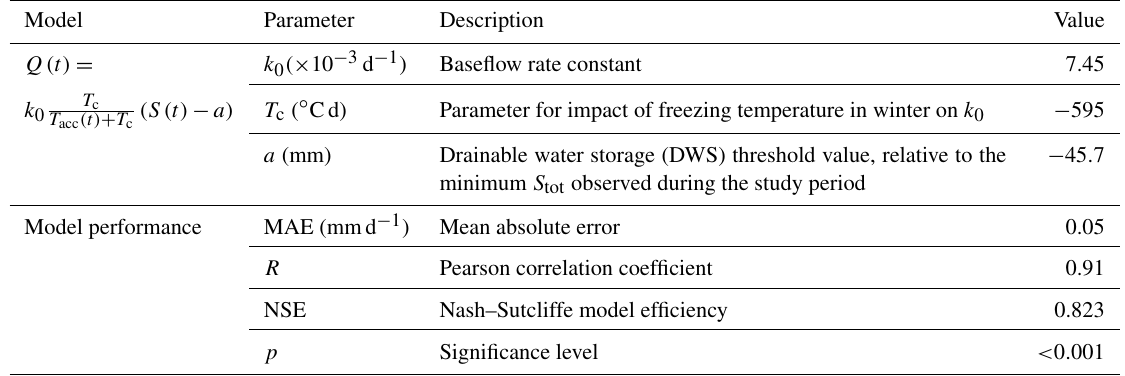
Table 1. Baseflow model calibration and test